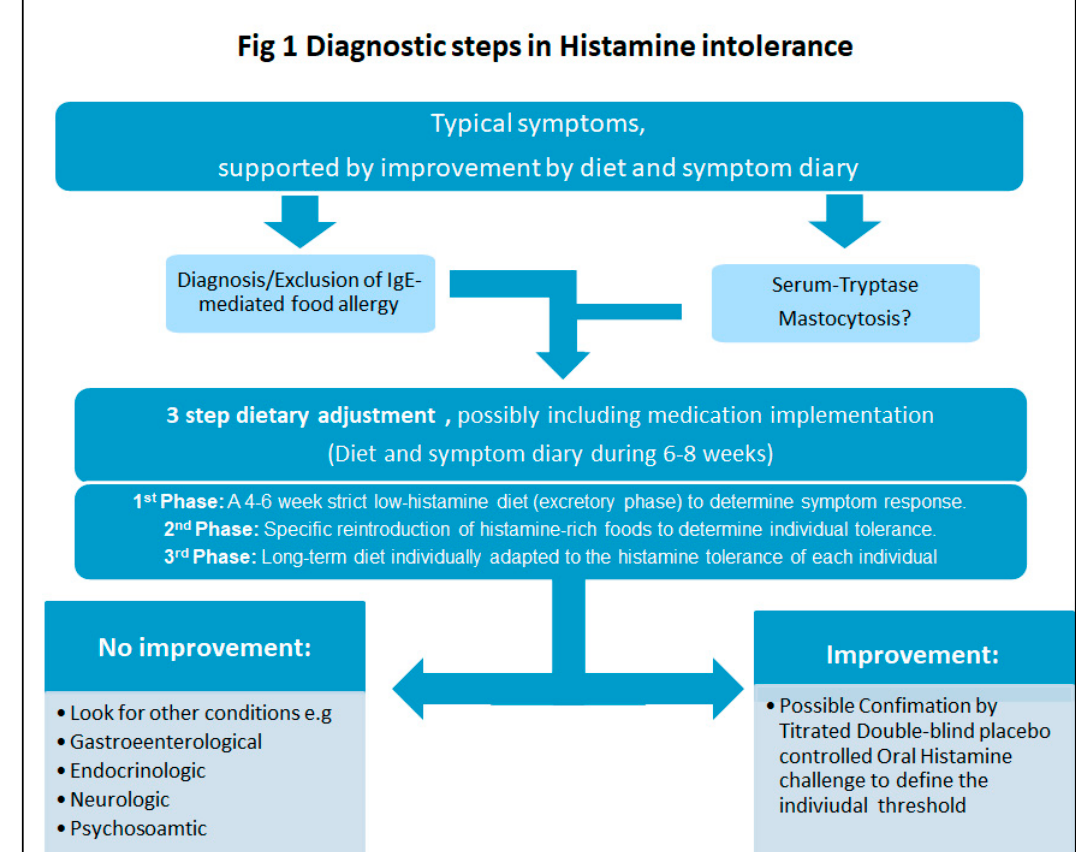
Figure 1. Diagnostic steps in Histamine intolerance. Modified by Reese et al. (2017) [58].